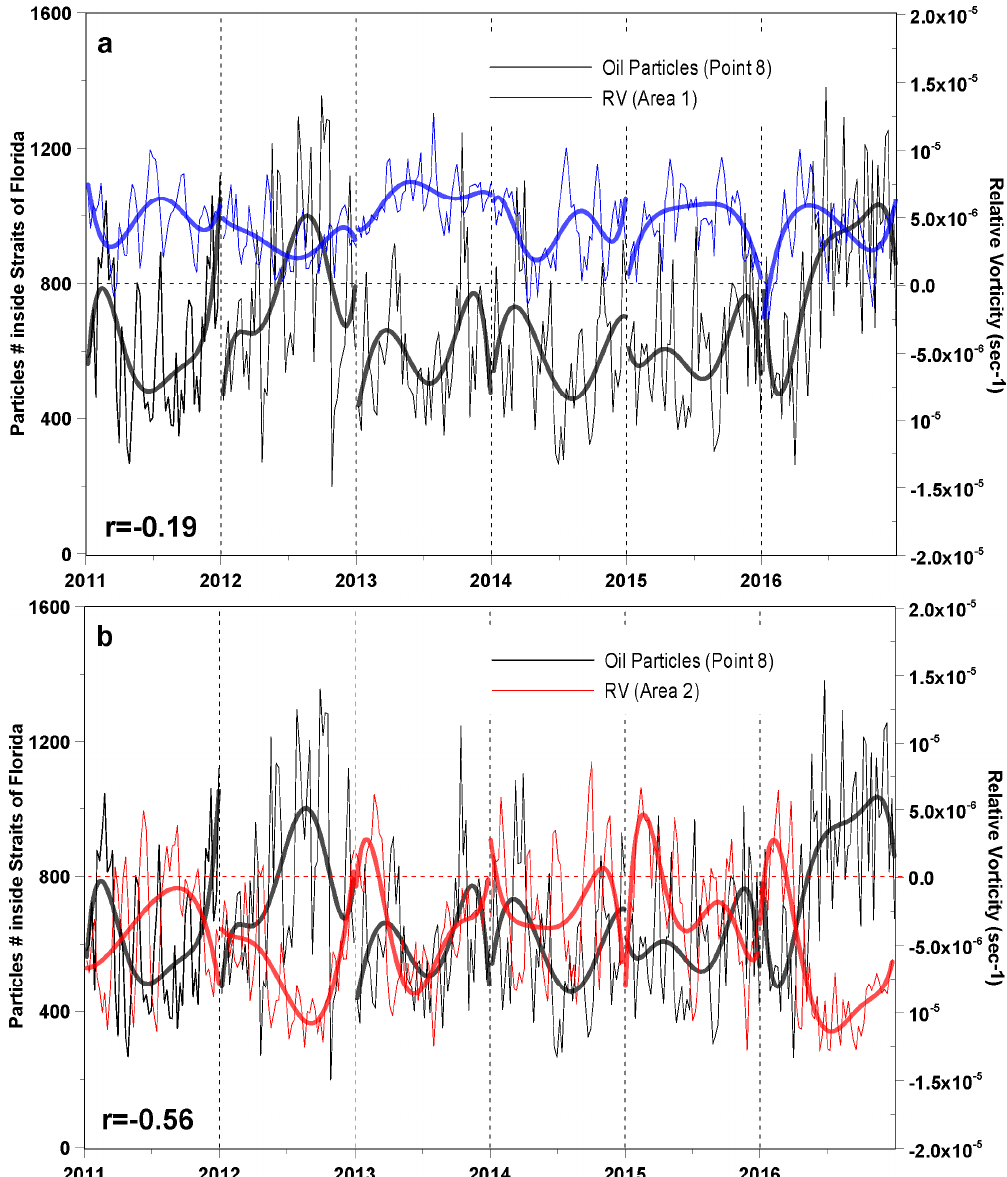
Figure 11. Time series of weekly number of oil elements (black line) that were released at Point 8 and computed inside the Straits of Florida (dashed box in Figure 1b), overlaid with the respective Relative Vorticity (RV; s − 1 ), averaged over ( a ) Area 1 and ( b ) Area 2. The annual polynomial fit (5th order) of each time series is also presented as a solid line. See Figure 1b for the position of Point 8 and definitions of Area 1 and Area 2.